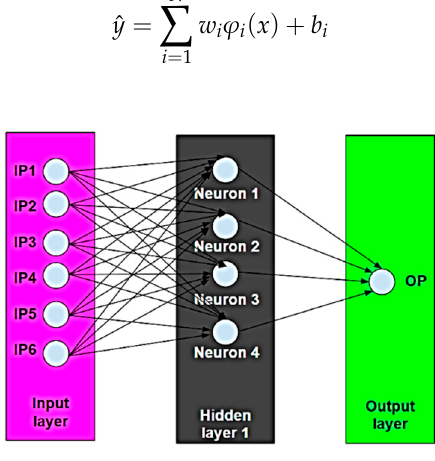
Figure 1. An example of artificial neural network (ANN) architecture (6-4-1).